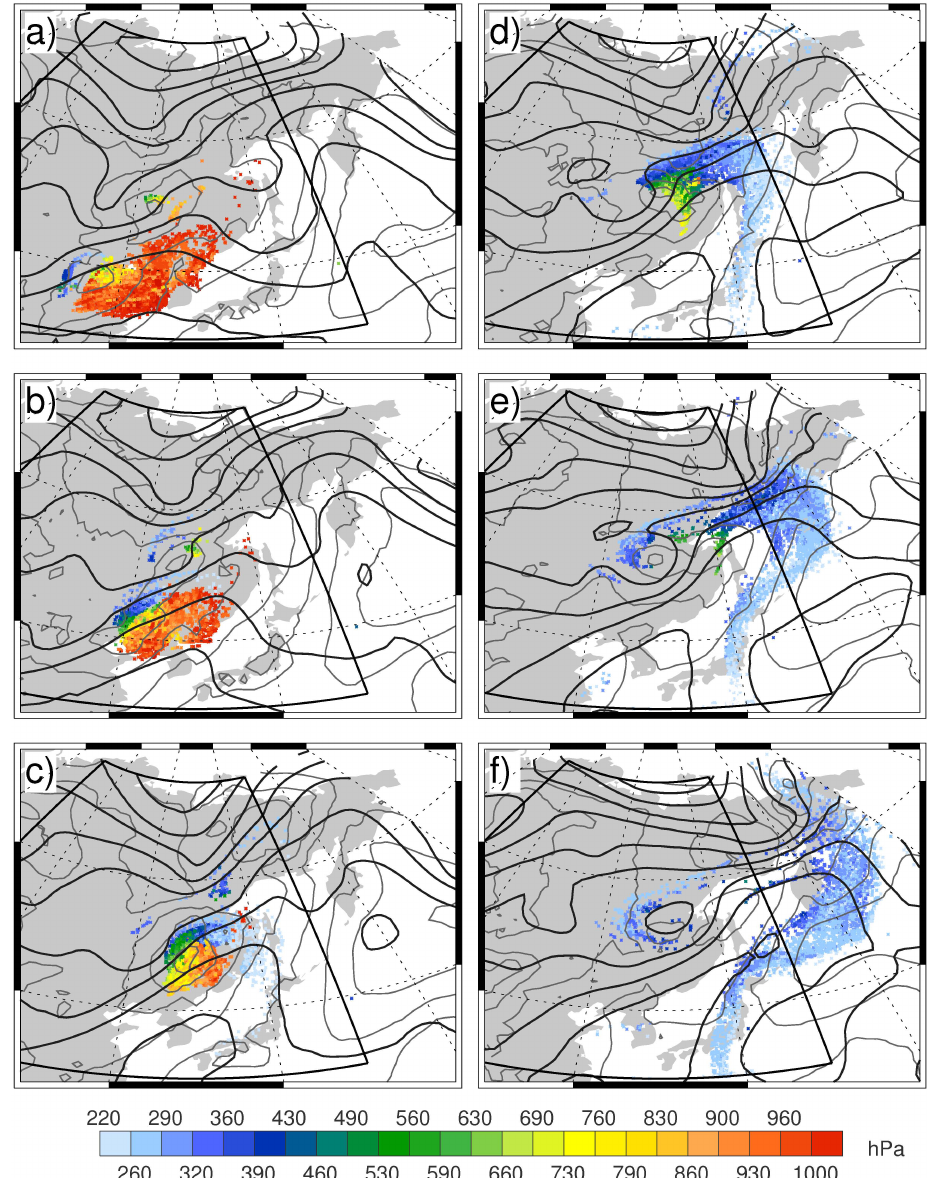
Fig. 5. Synoptic evolution from ECMWF analyses and position of WCB parcels at (a) 5 July, 00:00UTC; (b) 5 July, 12:00UTC; (c) 6 July, 00:00UTC; (d) 6 July, 12:00UTC, (e) 7 July, 00:00UTC, and (f) 7 July, 12:00UTC. Thick black lines show geopotential height at 300hPa (80gpm interval). Thin grey lines illustrate the mean sea level pressure (4hPa interval). The black polygon marks the region in which the trajectories were initialized (for details of the calculation method see Sect. 3.4). The colour-coded dots show location and pressure of the parcels at the respective time